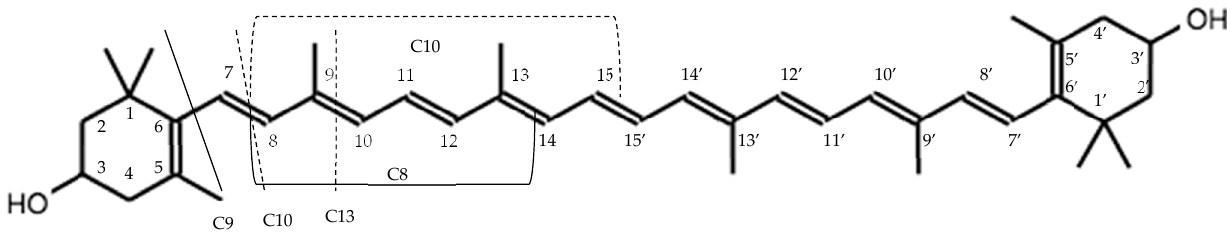
Figure 3. Zeaxanthin degradation by CCD, compounds generation in C9 (4-ketoisophorone, isophorone, dihydrooxophorone, 2-hydroxy-isophorone); C10 safranal similar structures (HTTC, 5,5-dimethyl-2-methylene-3-cyclohexene-1-carboxaldehyde, 3,3,4,5-tetramethylcyclohexan-1-one, 2,6,6-trimethyl-4-oxo-2-cyclohexen-1-carbaldehyde, -cyclocitral, 2,4,4-trimethyl-3-carboxaldehyde-5-hydroxy-2,5-cyclohexadien-1-one); C11 (-homocyclocitral) and C13 (ionone, 2-cyclohexen-1-ol, 3-(1-buten-1-yl), 2,4,4-trimethyl, megastigma-4,6( E ),8( E )-triene).